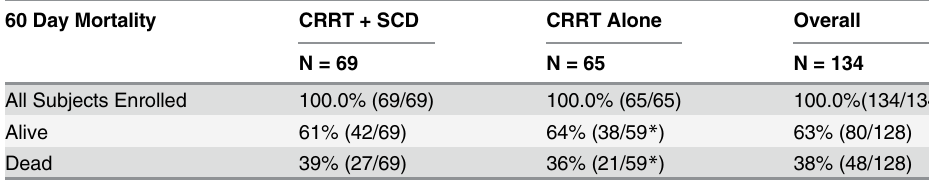
secondary endpoint of dialysis dependency. Dialysis dependency (Table 8) showed a borderline statistically significant difference between the patients maintained for (cid:3) 90% of the treatment in the protocol ’ s riCa target range of (cid:1) 0.4 mmol/L over those at (cid:1) 90% of the treatment Table 4. 60 Day Mortality by Intention to Treat Analysis.